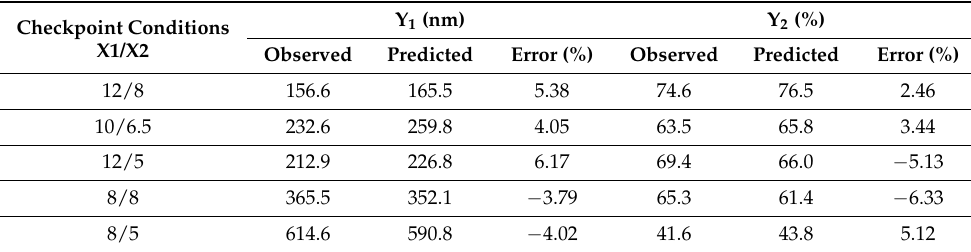
Table 5. Validation of prepared